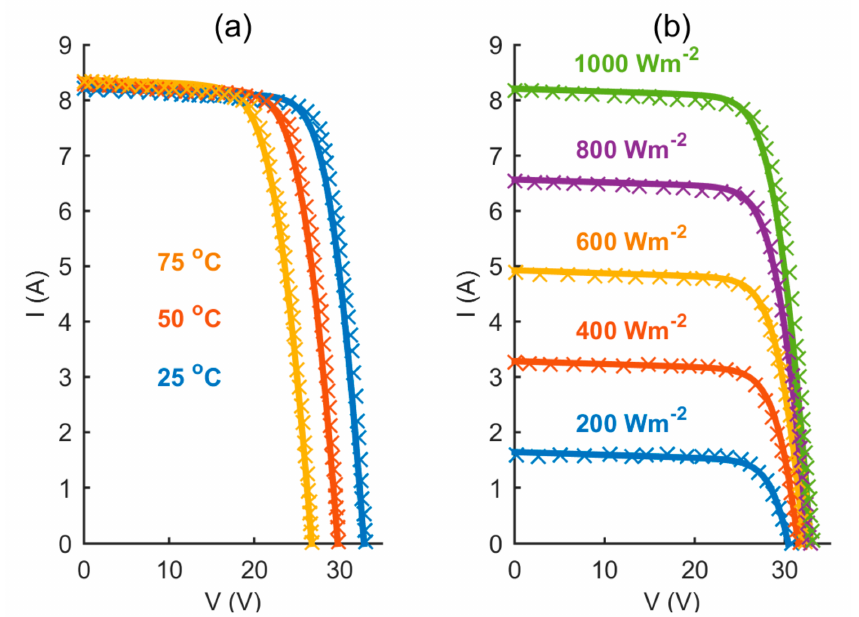
Figure 5. Validation of electrical output of the numerical model (I-V curves) where solid lines represent numerical results while × represents experimental results ( a ) different temperature ( b ) different irradiances.